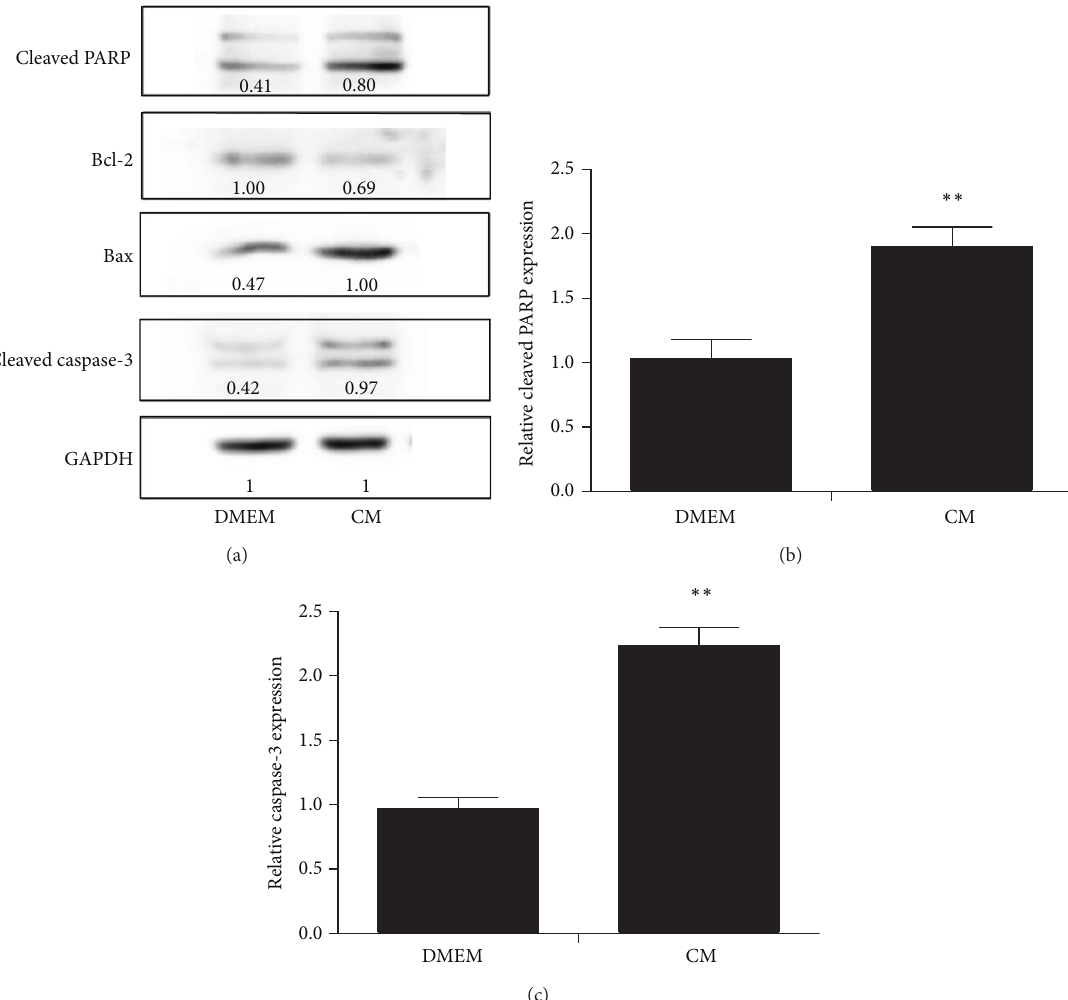
Figure 6: After treatment with ADSC-CM, the expression of antiapoptotic gene products Bcl-2 was inhibited but the expression of apoptotic gene product Bax was upregulated (a). Cleaved PARP (b) and Caspase-3 (c) showed a higher expression in the ADSC-CM treated group. Relative gray values of each protein band were marked under the bands which were measured by Image J software. Data presented are the mean ± SD of three independent experiments ( ∗ 𝑃 < 0.05